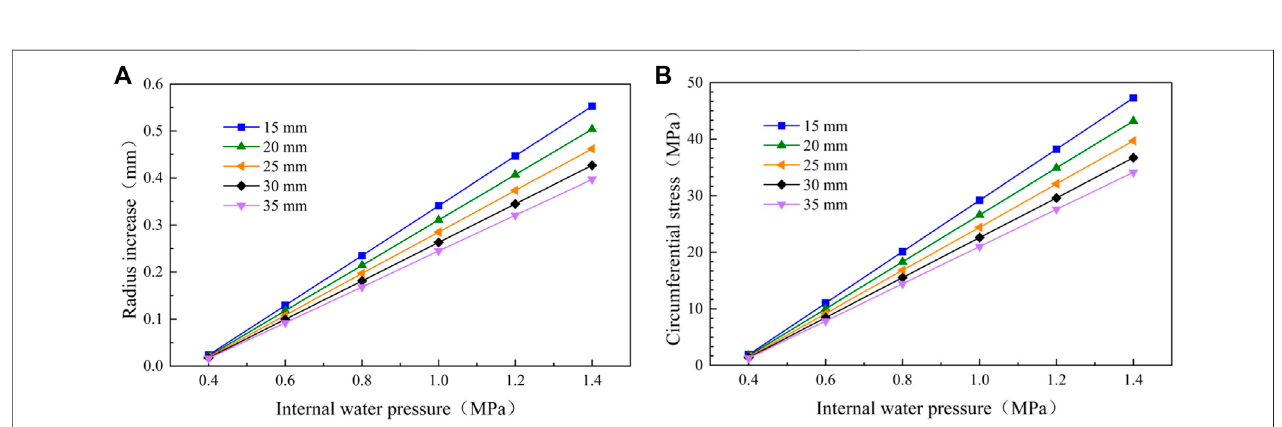
FIGURE 12 | In fl uence of thickness of steel pipe lining on structure under different internal water pressure. (A) Inner radius increment. (B) Circumferential stress at the inner radius.